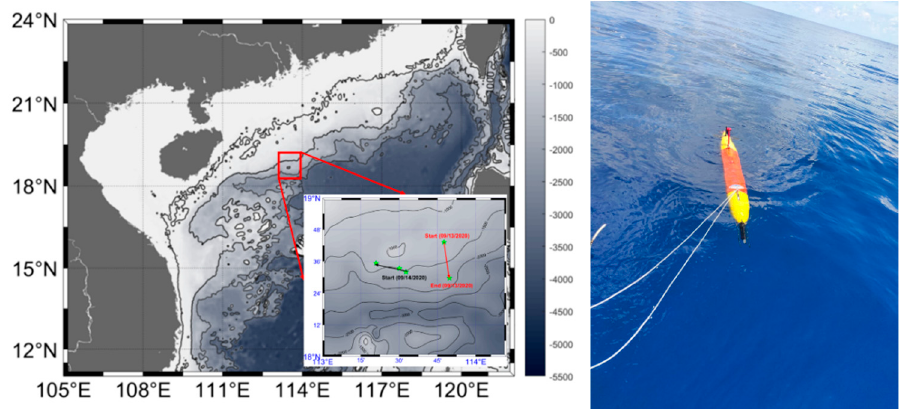
Figure 12. Bathymetry contours (in meters) of the northern South China Sea. The red rectangle indicates the location of the experiment. The enlarged view shows the track (red lines) of the turbulence AUV on 13 September 2020. The right picture is retrieved turbulence AUV from research vessel.